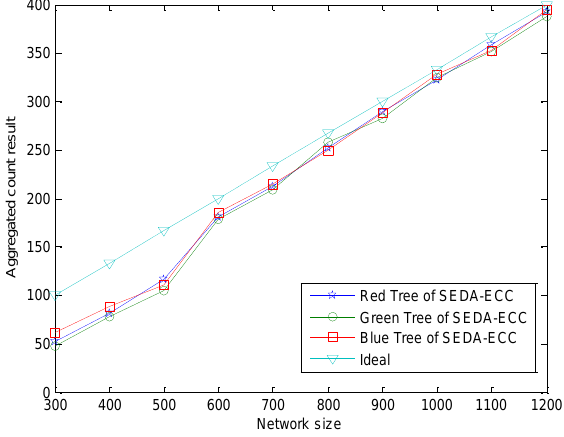
Figure 5. Difference value among aggregated count results from three subtrees without